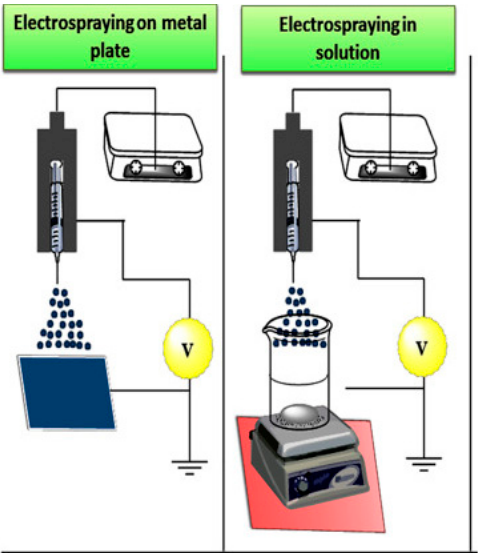
Figure 2. Illustration of a setup of the electrospray method, reprinted with permission from [75], 2018, Elsevier.